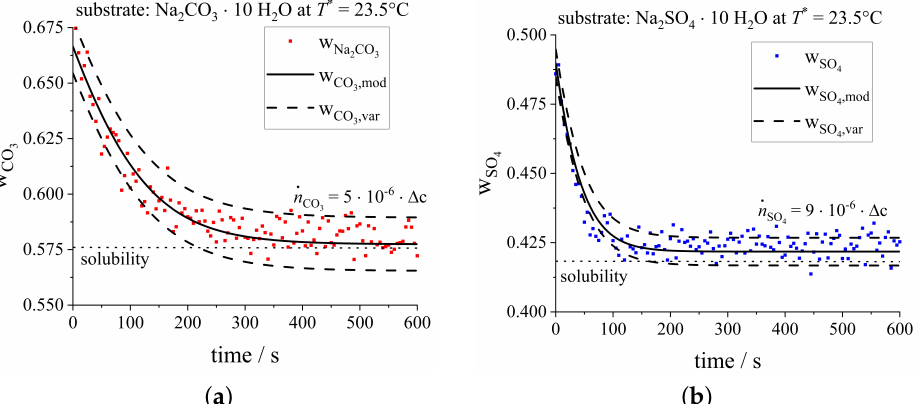
Figure 8. Desupersaturation courses from Figure 6 of the two binary material systems calculated with mean growth kinetics. Diagram ( a ) displays the course of sodium carbonate decahydrate, while ( b ) illustrates the crystallization of sodium sulfate decahydrate. The given equations were used to calculate the black solid lines. The black dashed lines represent the accuracy range, taken as the measurement uncertainty of a Raman measurement for sodium carbonate and sodium sulfate, respectively. Further diagrams of mean desupersaturation courses and calibration data are provided in the supporting information (compare Figures S11 and